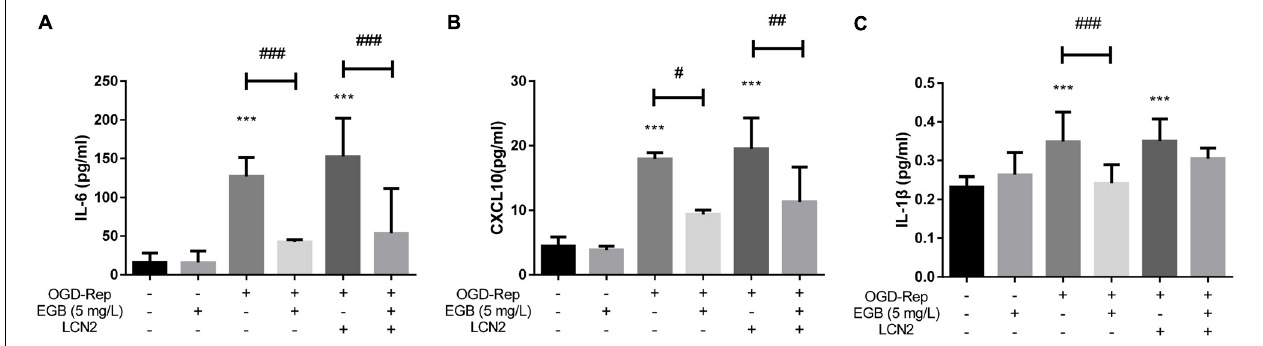
FIGURE 5 | EGB suppressed OGD-induced inflammation in astrocytes in vitro . (A–C) Analysis showing the relative levels of the pro-inflammatory mediators IL-1 β , IL-6, and CXCL10 (IP-10). Data are expressed as mean ± SEM ( n = 5). ∗ p < 0.05, ∗∗ p < 0.01 and ∗∗∗ p < 0.001 vs. control group; # p < 0.05, ## p < 0.01 and ### p < 0.001 and vs. the indicated groups.